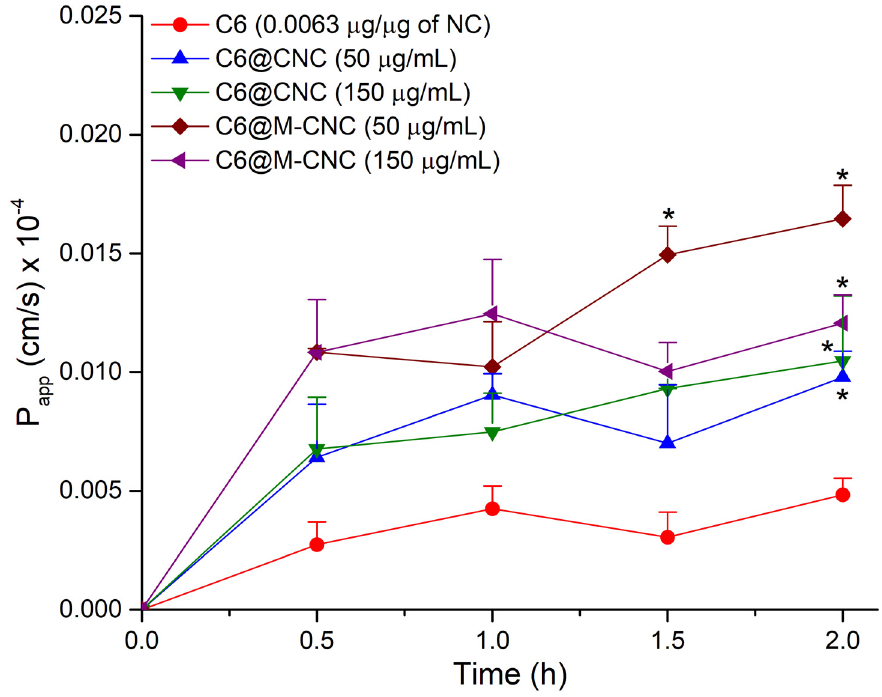
Figure 9. The P app of C6 from C6@CNCs and C6@M-CNCs (50 and 150 µg/mL) across Caco-2 monolayers. Results are presented as mean ± SEM ( n = 3). Data points significantly different ( p < 0.05) from the corresponding C6-only values are marked with an asterisk.